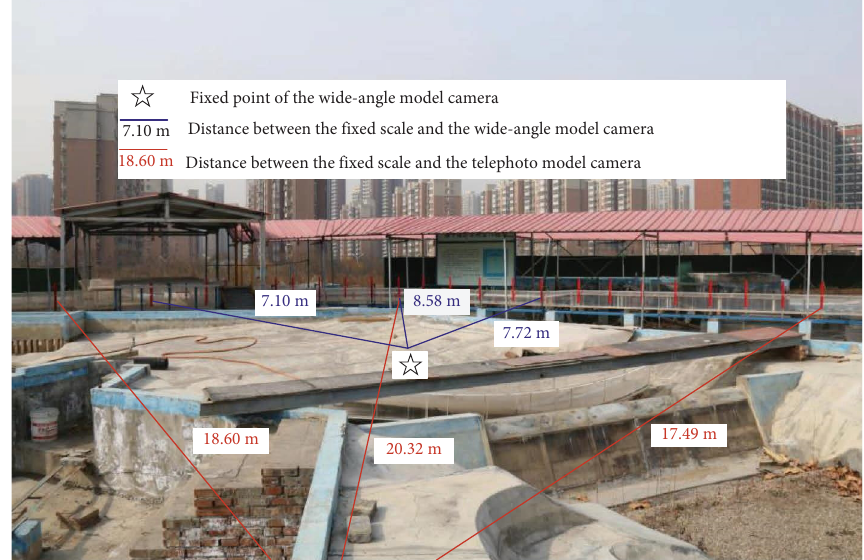
Figure 2: Te position relationship between the single camera position and the fxed scale (two options).